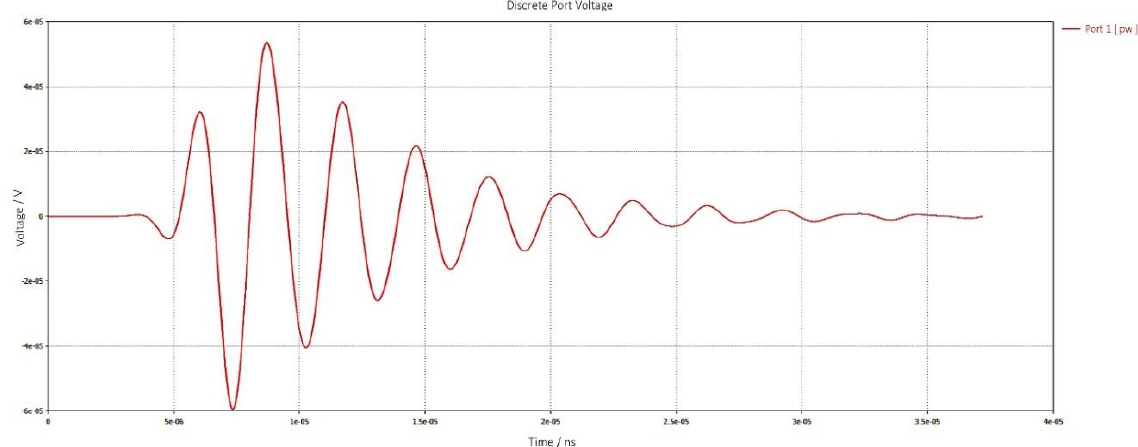
Figure 13. Open circuit voltage of the dipole when the load is not connected.